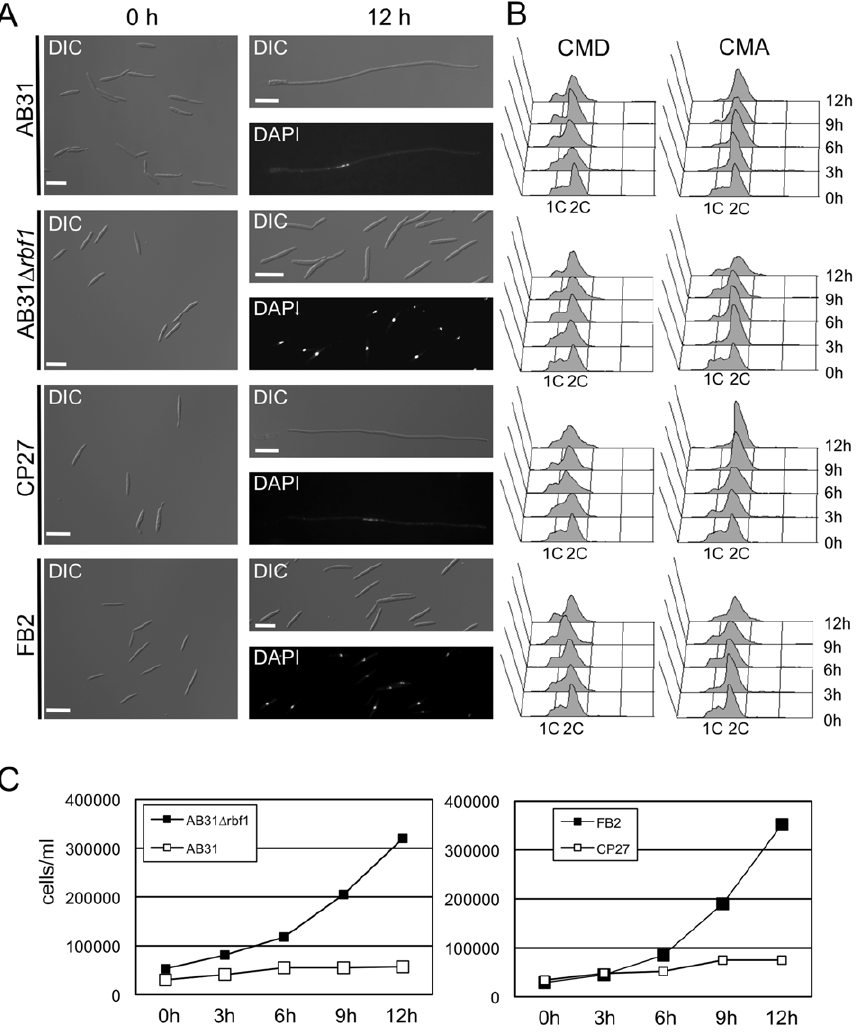
Figure 4. rbf1 is required and sufficient for b -dependent filamentation and G2 cell cycle arrest. ( A ) Microscopic analysis of AB31, AB31 D rbf1 , CP27 (FB2 D b::P crg1 :rbf1 ) and FB2 after induction of the active bE1/bW2-heterodimer or Rbf1, respectively. Filament formation was observed 12 hours after b -induction in strain AB31 and rbf1 -induction in strain CP27 (FB2 D b::P crg1 :rbf1 ). In contrast, strain AB31 D rbf1 did not switch to filamentous growth and continued to grow by budding, similar to the FB2 strain that was used as negative control. Scale bar=10 m m. ( B ) FACS analysis of AB31, AB31 D rbf1 , CP27 (FB2 D b::P crg1 :rbf1 ) and FB2 under non inducing conditions (CMD) or inducing conditions (CMA). Induction of the active bE1/bW2 combination in AB31 or induction of rbf1 in strain CP27 resulted in an enrichment of cells with a 2C content, indicative of a G2 cell cycle arrest. In AB31 D rbf1 no enrichment of cells with 2C was observed, similar to control strain FB2. ( C ) Measurement of cell numbers/ml in strains AB31, AB31 D rbf1 , CP27 (FB2 D b :: P crg1 :rbf1 ) and FB2 grown in CMA for the time indicated. Strains AB31 D rbf1 and FB2 show a typical exponential growth curve, whereas strains AB31 and CP27 stopped to grow after induction of the bE1/bW2-heterodimer or rbf1 , respectively, indicating a cell cycle arrest.